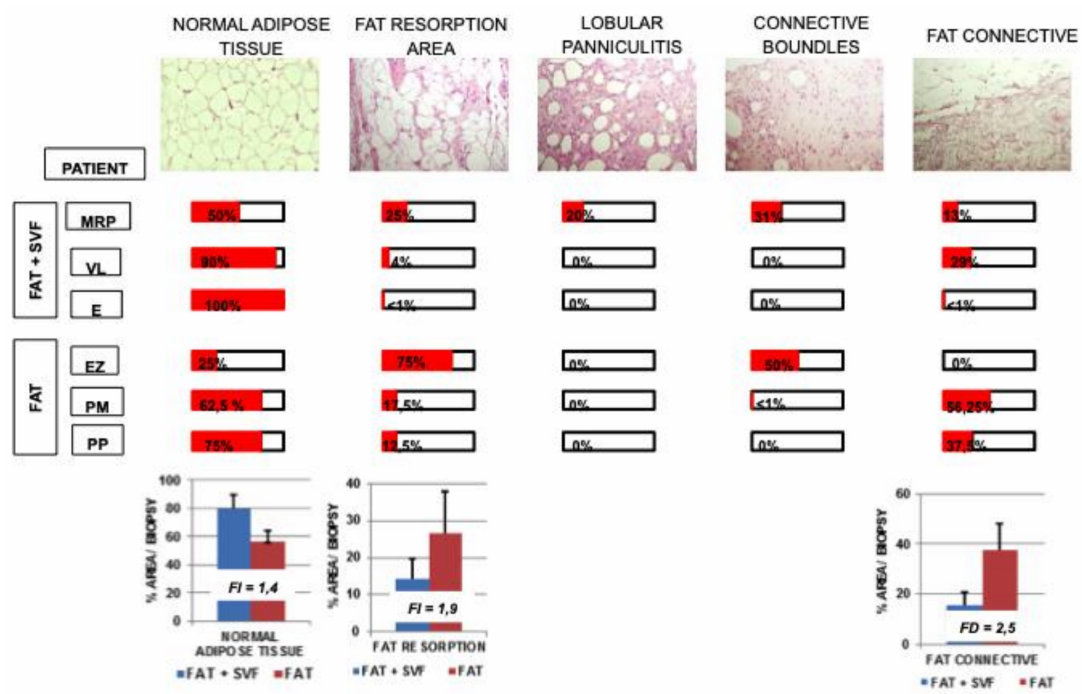
Figure 4. Tissue distribution of identified histological features within the sections for randomized selected